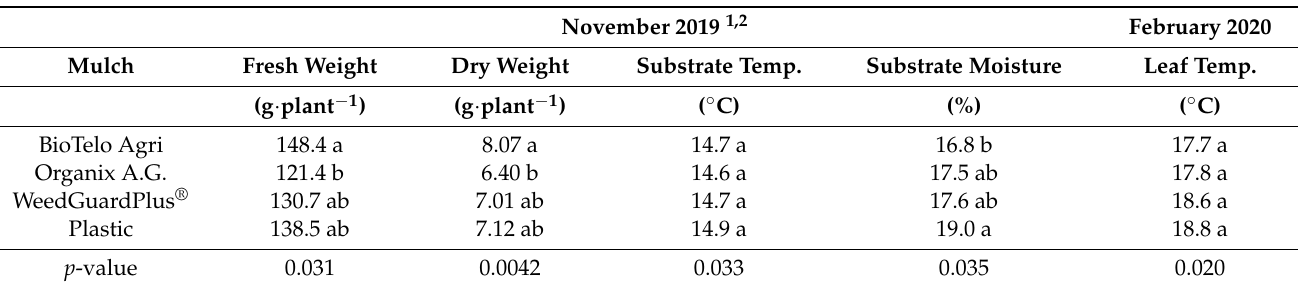
Table 4. Fresh and dry plant weights, substrate temperature, moisture, and leaf temperature affected by mulch type in the production of Asian leafy greens in a high tunnel in the November and February